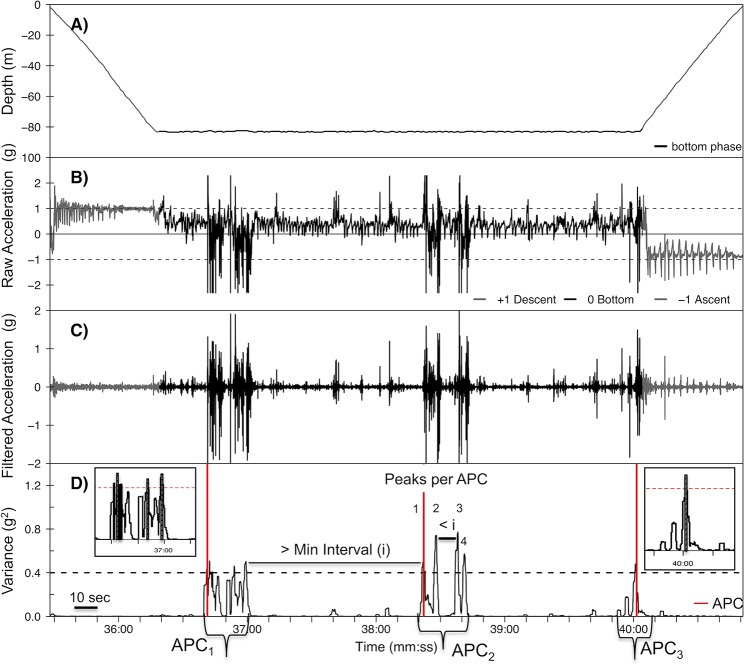
Diagram of accelerometer data processing method.Example of accelerometer identification of attempted prey captures (APC) with variance of acceleration on the surge axis. Dive depth (A) was synchronized with raw acceleration (g, B) as evident by the bottom phase of the dive matching on A and B. Head movements were isolated from body movements with a 3 Hz high-pass filter (C) and variance of acceleration (g2) was calculated for each individual dive (excluding surface ≥ 2 m). Peaks in variance of acceleration above a variance threshold (——) and within a minimum time interval (i) were used to estimate APC (APC, D). Consecutive peaks greater than the minimum interval apart were counted as separate APC, and events less than the interval were counted as single APC. Duration of individual APC (indicated by brackets), integral area under the peak of variance (g2, inset, cumulative integral of individual peaks in APC group), time of the first peak in each APC (−), and number of peaks per APC were also calculated.